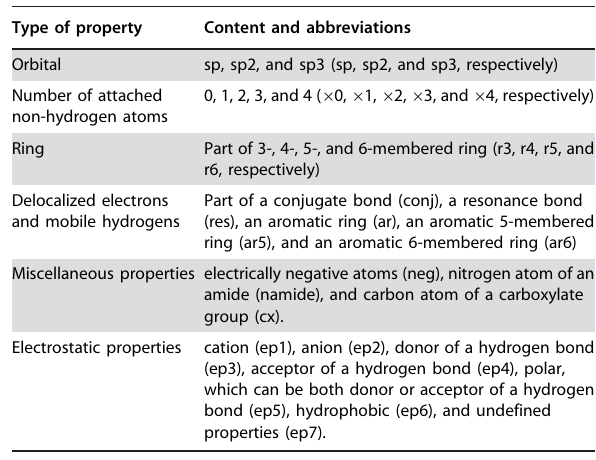
Table 1. Physicochemical properties defined